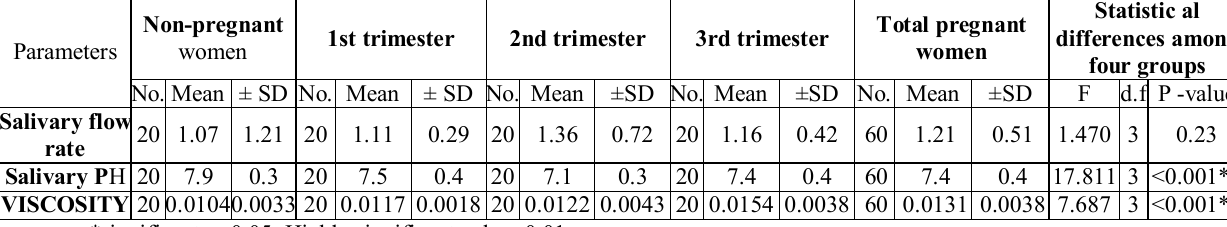
Table 3: Salivary physico chemical characteristic among non- pregnant and pregnant women according to